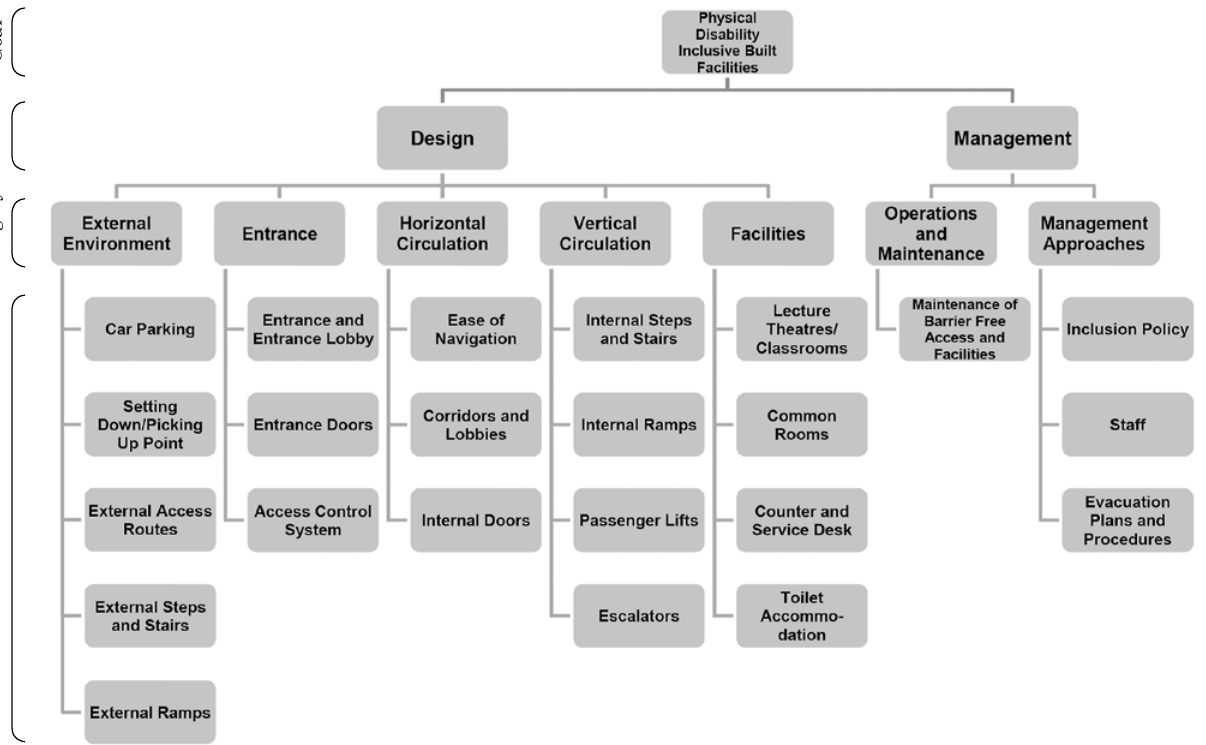
Fig. 1. Hierarchy of assessment attributes in relation to the physical disability inclusiveness of university buildings